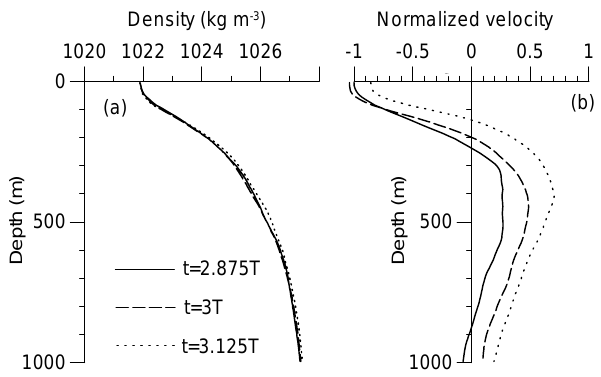
Fig. 9. Vertical profiles of density and normalized horizontal veloc- ity taken in the middle sections of the wave fragments III shown in Fig. 7f, g and h at t = 2 . 875 T , 3 T and t = 3 . 125 T .